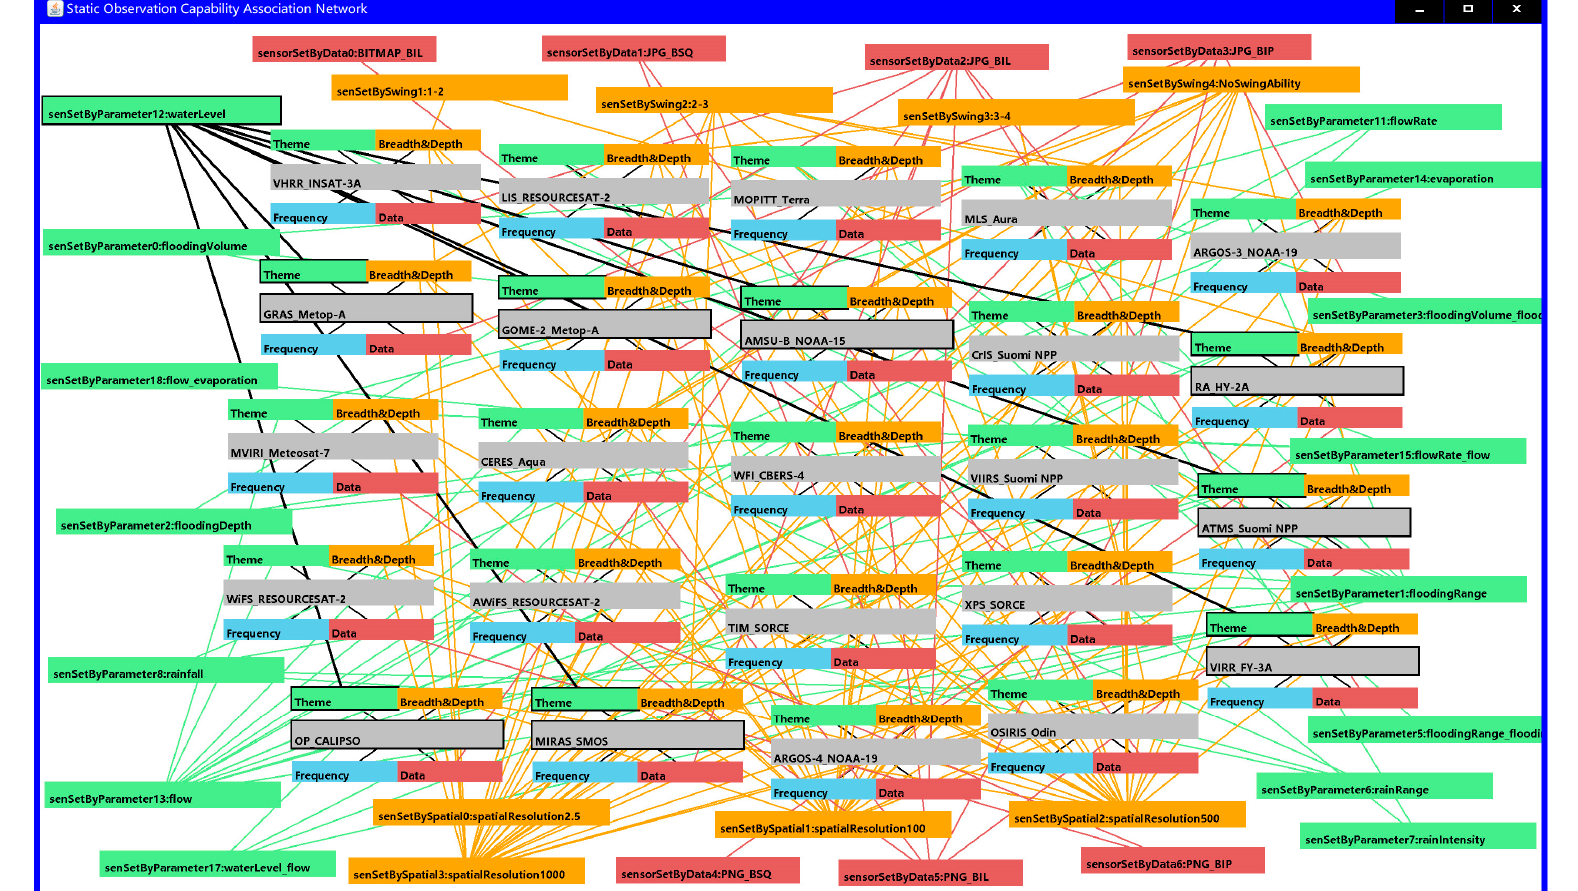
Figure 13. Example of the static observation capability association network for the qualified satellite sensors.